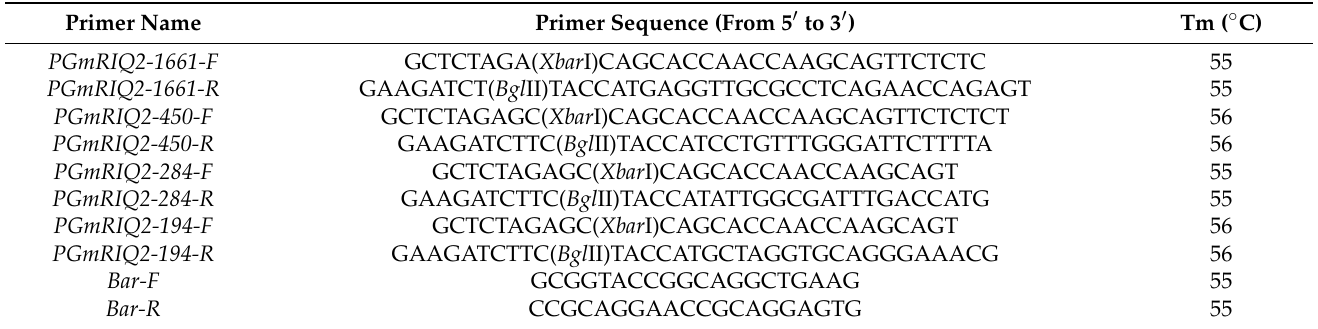
Table 1. List of primers used for PCR.